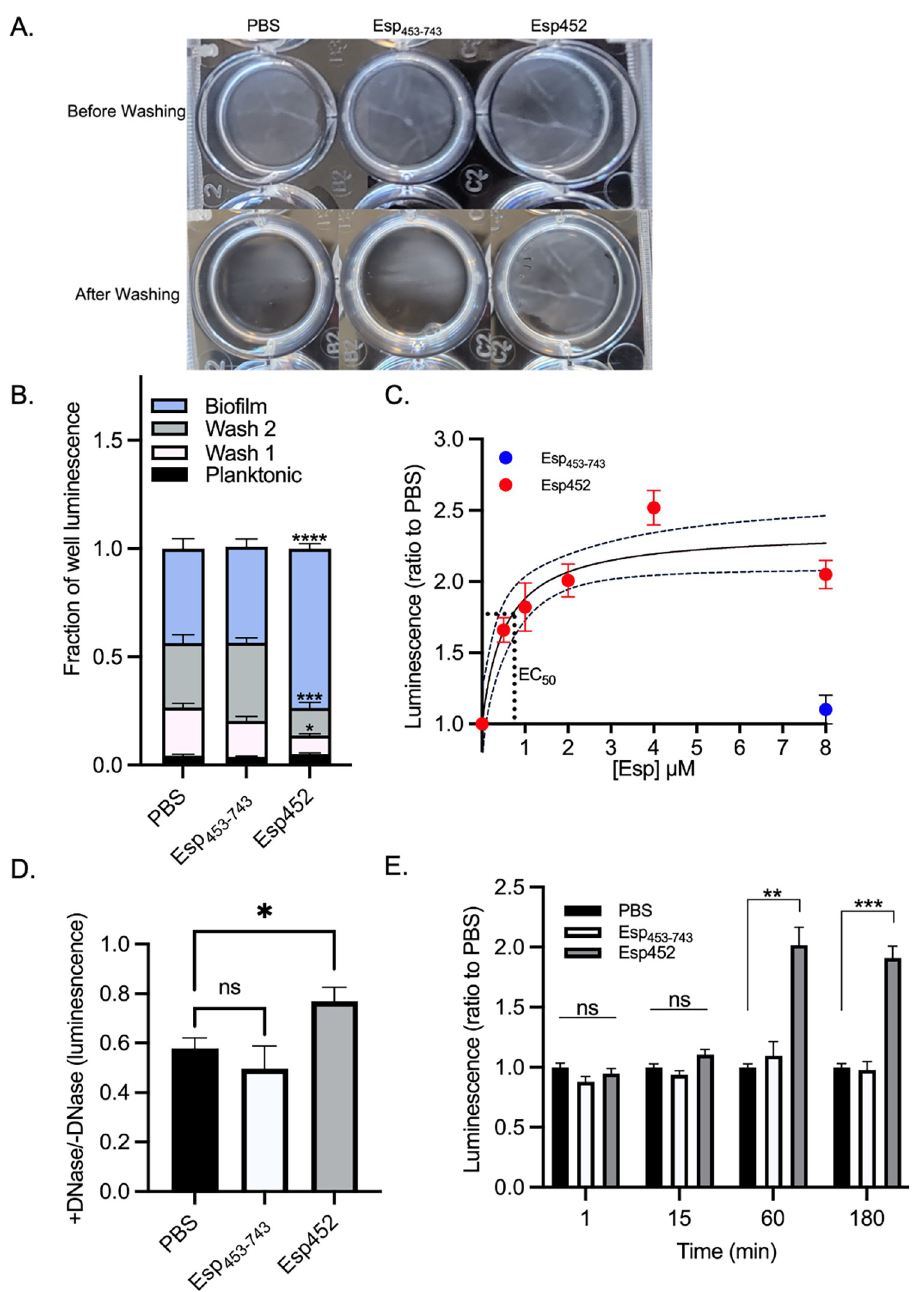
Fig 2. Strengthening of enterococcal biofilms by Esp452. A. MMH594b ( Δ esp ) biofilms grown with PBS, Esp 453-743 , or Esp452 before (top) and after (bottom) washing. B. Proportion of total luminescence from luciferase generated by the planktonic fraction, wash fractions, or biofilm fraction of E . faecalis MMH594b biofilms grown with PBS, Esp 453- 743 , or Esp452. Samples were collected in triplicate for each of three independent experiments. Each luminescence measurement was divided by the total luminescence of the corresponding well. The standard error of the mean (SEM) is indicated with error bars. Esp 453-743 and Esp452 fractions were compared to the corresponding PBS fraction by 2-Way ANOVA and Tukey’s post hoc test. All significant results are indicated on the graph. � p < 0.01, ��� p < 0.0001, ���� p < 0.00001. C. Luminescence of biofilm fraction for MMH594b ( Δ esp ) biofilms grown with Esp452 (red circles) at varying concentrations or with Esp 453-743 (blue circle) at 8 μ M, divided by the average luminescence of biofilm fractions for biofilms grown with PBS. Samples were collected in duplicate for each of three independent experiments. The SEM is indicated with error bars. The 95% confidence interval (CI) of the dose-response curve is indicated in dashed lines. The EC 50 is indicated with the dotted line. D. Luminescence of biofilm extract of MMH594b biofilms